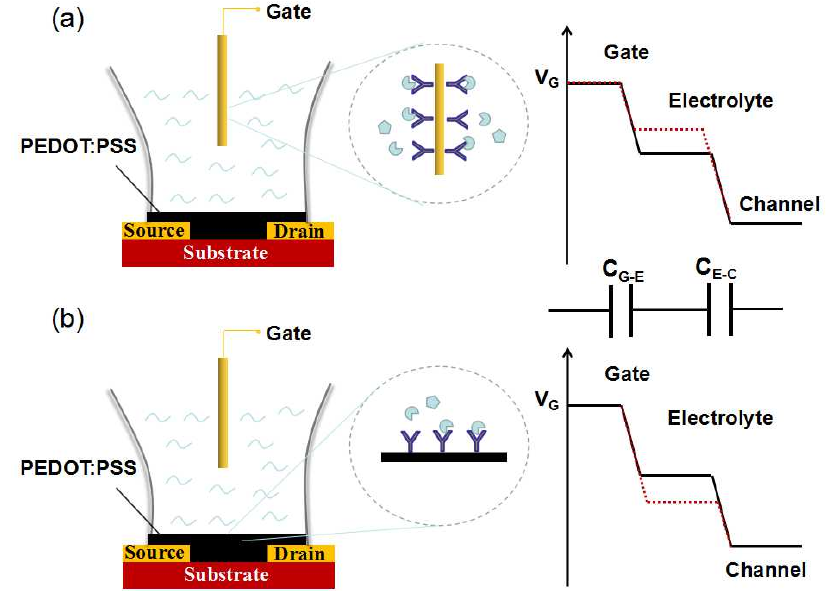
Figure 2. Schematic diagram of an OECT: ( a ) gate surface as the sensing interface, the potential distribution between gate and channel is changed by the reaction on the gate; ( b ) channel surface as the sensing interface, the potential distribution between the gate and channel is changed by the reaction on the channel.